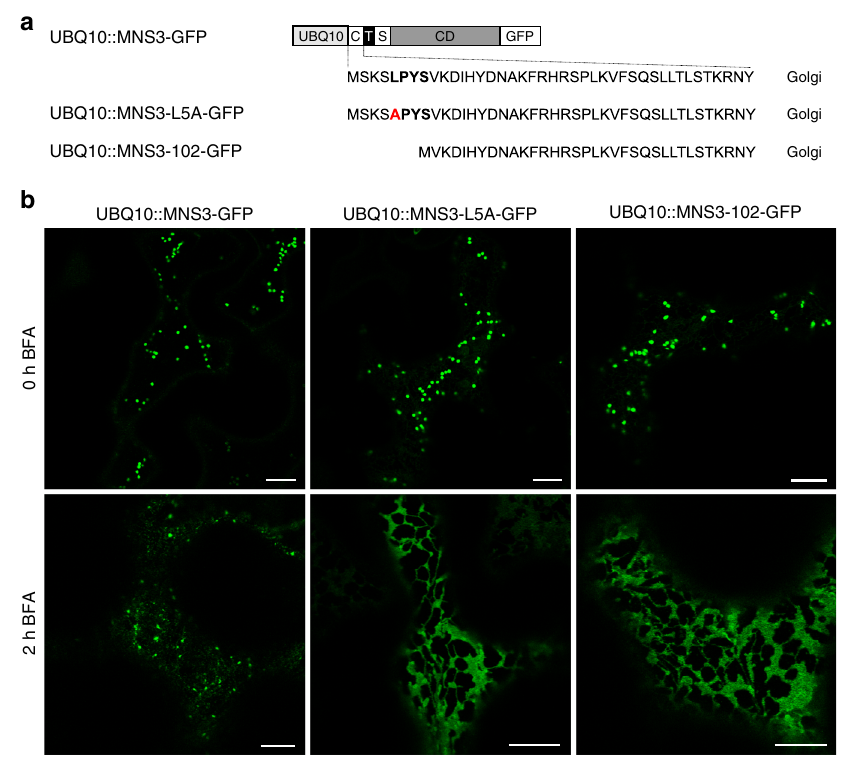
Fig. 8 Subcellular localization of MNS3 tail mutants before and after BFA treatment. a Schematic illustration depicting the domain structure of MNS3-GFP carrying the wild type, mutated (L5A), or truncated (102) cytoplasmic tail expressed under the control of the UBQ10 promoter. b Confocal images of representative N . benthamiana leaf epidermal cells showing the subcellular localization of wild-type UBQ10::MNS3-GFP, mutated UBQ10::MNS3-L5A-GFP, and truncated UBQ10::MNS3-102-GFP before and after 2 h of BFA treatment. Images were acquired 2 dpi. Scale bars = 10 µ